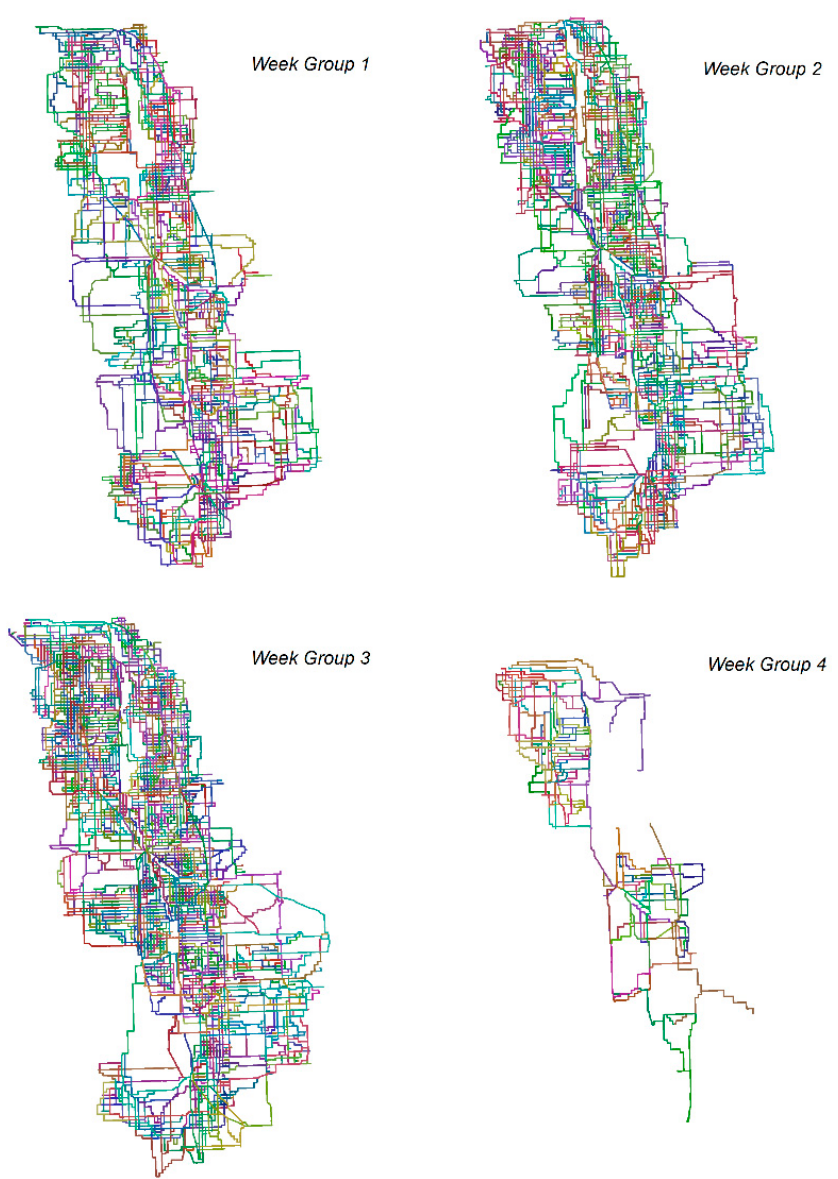
Figure 6. Closest facility solution routes.